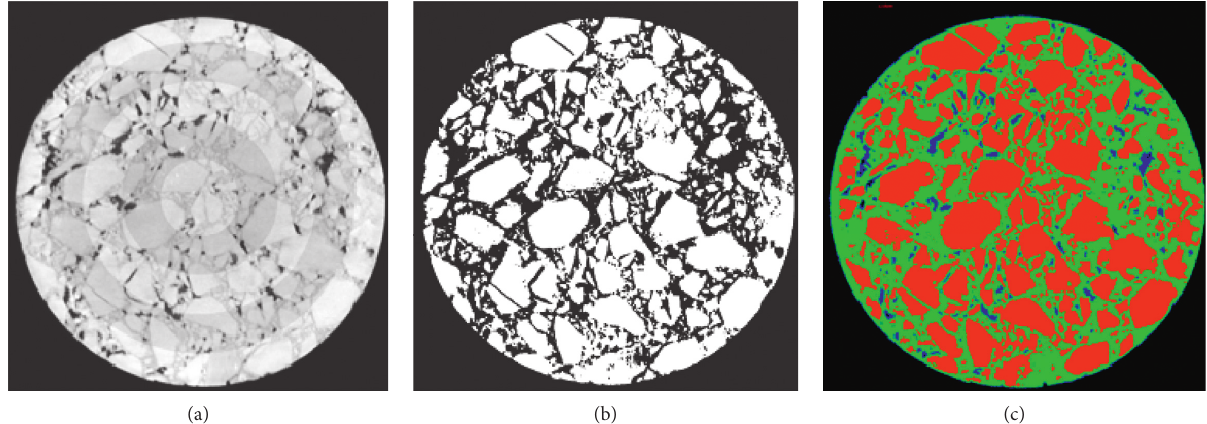
Figure 3: Segmentation image processed by 5-ring blocking [18]. (a) Segmentation with 5 rings (b) After segmentation with 5 rings. (c) After processed with segmentation and Otsu’s method.